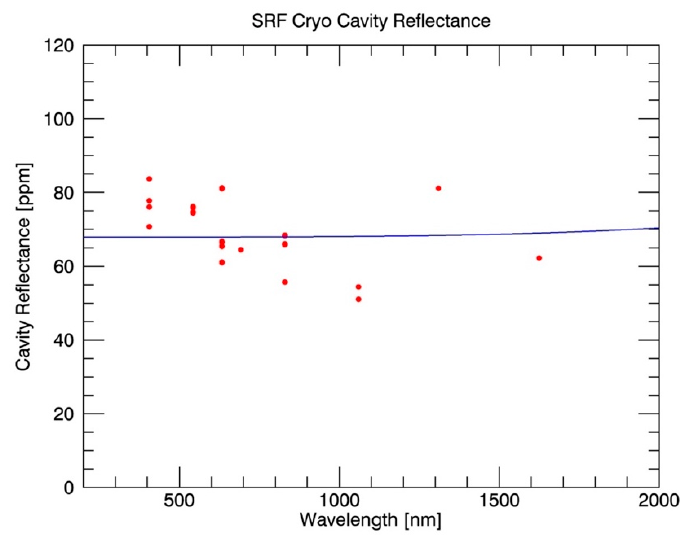
Figure 6. The L-1 CR cone cavity reflectance measurements from 400–1620 nm. All NIST Si trap measurements were completed at 532 nm, where reflectance was quantified at 70 ± 40 ppm (k = 1).